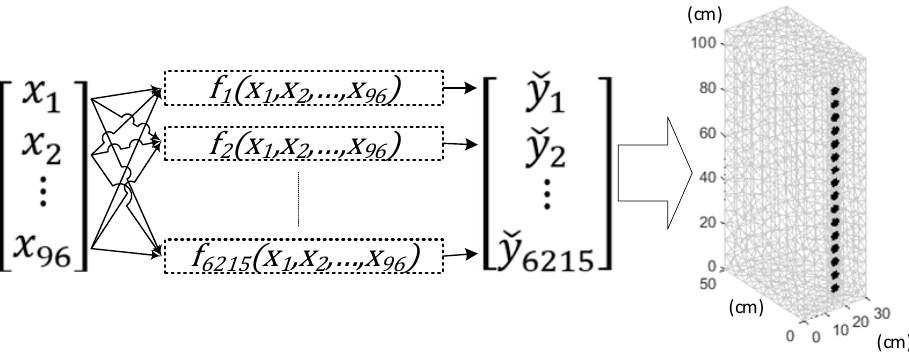
Figure 7. The concept of transforming the measurement vector x into a set of individual pixels of the reconstructed images y ̌ by using a multifunctional approach